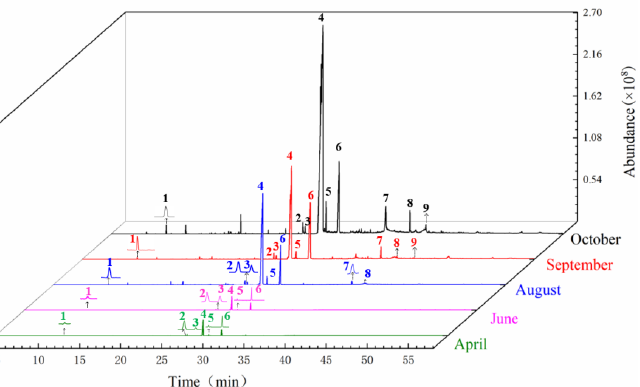
Figure 3. Changes of chemical components in the head of A. sinensis in different periods.